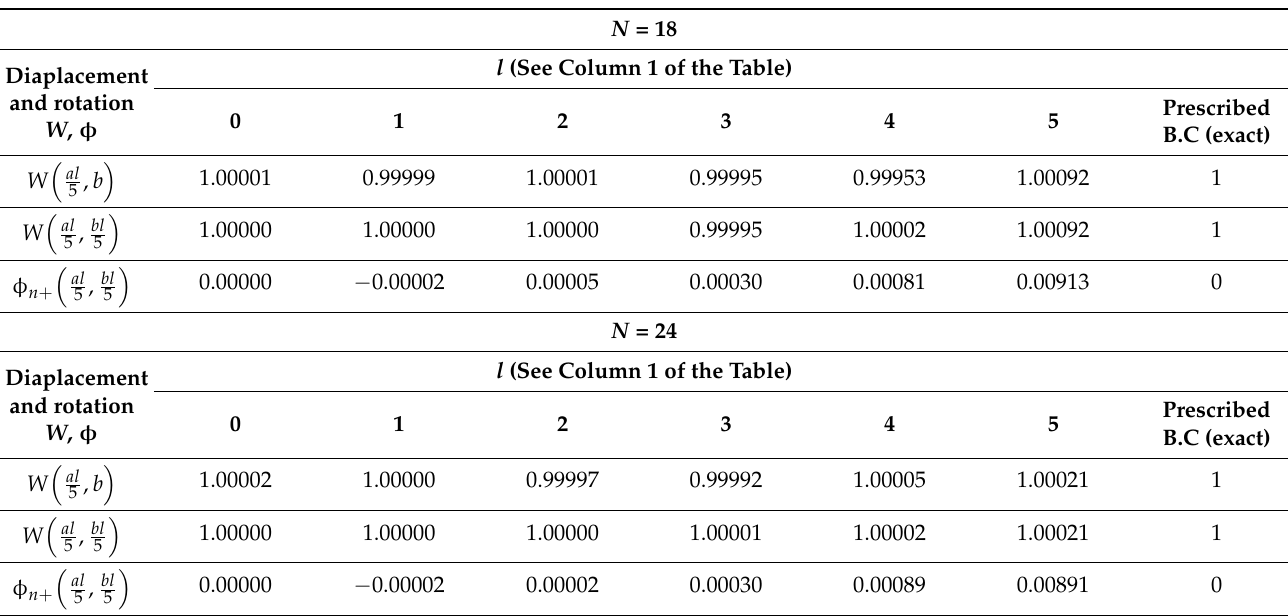
Table 1. Fulfilling the prescribed boundary conditions test for a right triangular epoxy-glass plate. N = 18